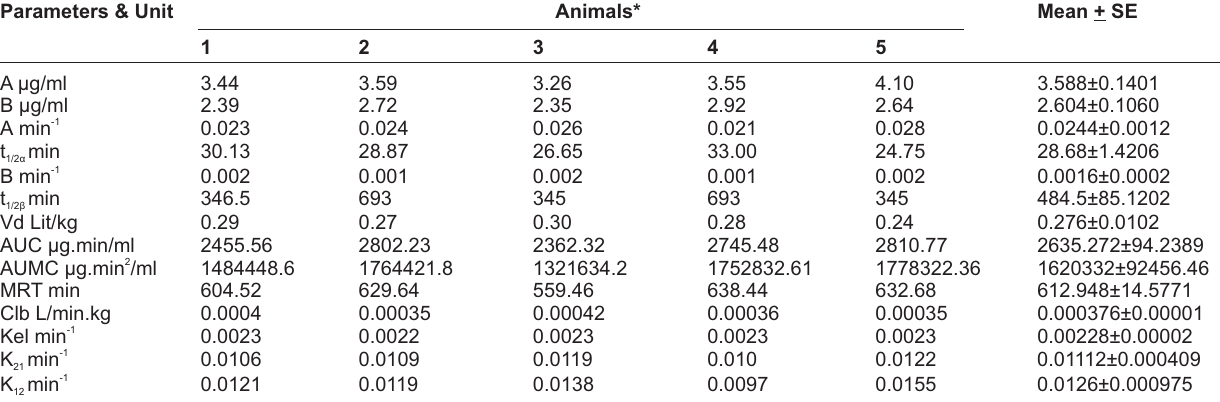
Table-2. Pharmacokinetics of Meloxicam after single intravenous administration at the dose rate of 1 mg/kg body weight in goat. Parameters &